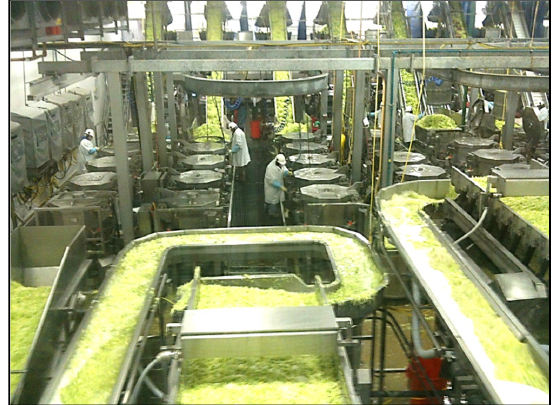
Figure 3. Salinas lettuce cutting and rinse operations contribute to “ag wash water”, one of four new water sources collected for the Pure Water Monterey project (photo by R.G.L).